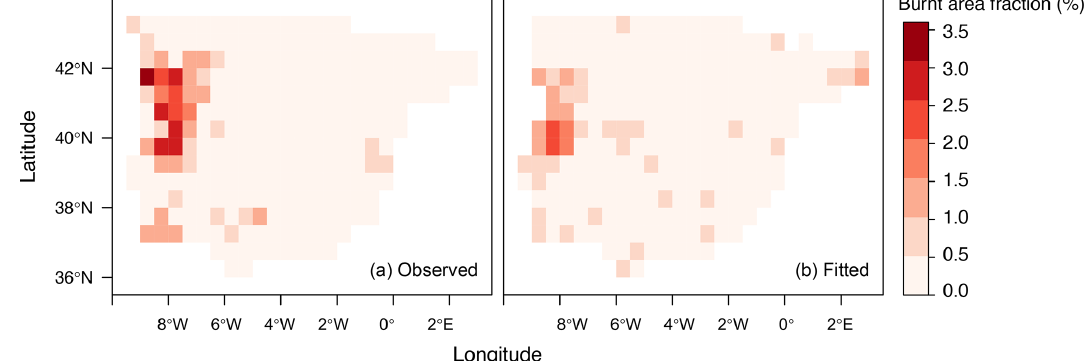
Figure 3. Mean (over 16 years) of observed (a) and fitted (b) values of burnt area